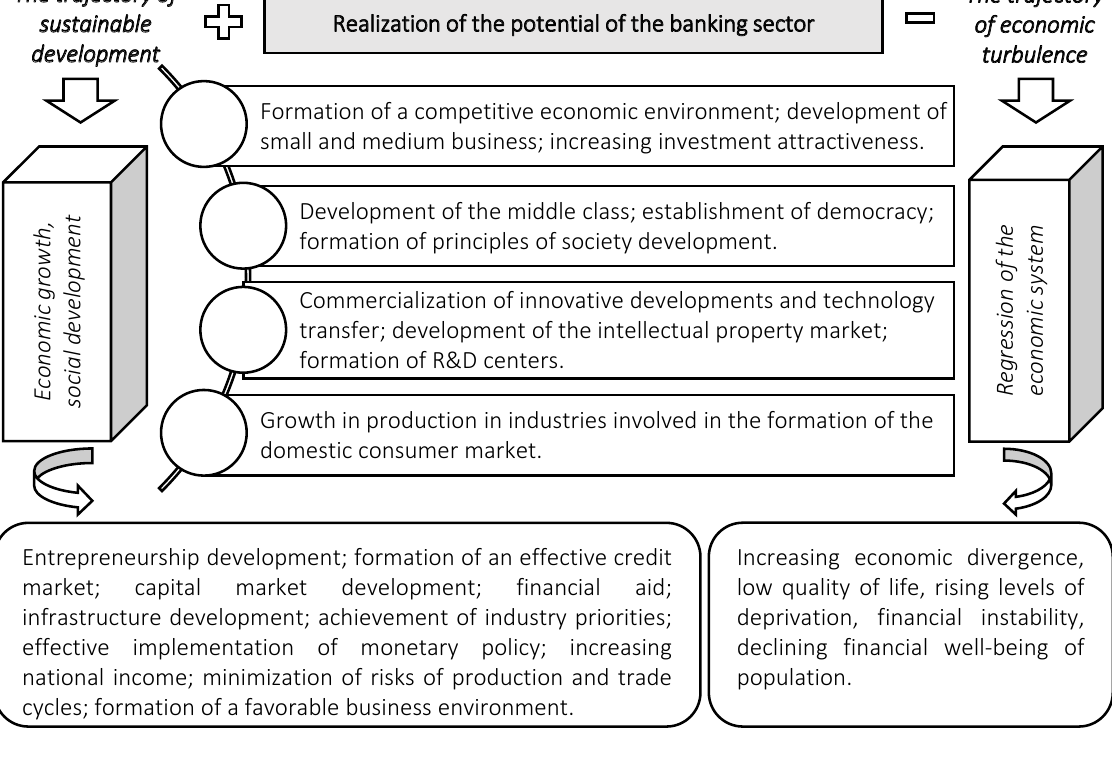
Figure 1. Conceptual vision of the banking sector’s place and role in ensuring strategic sustainable economic